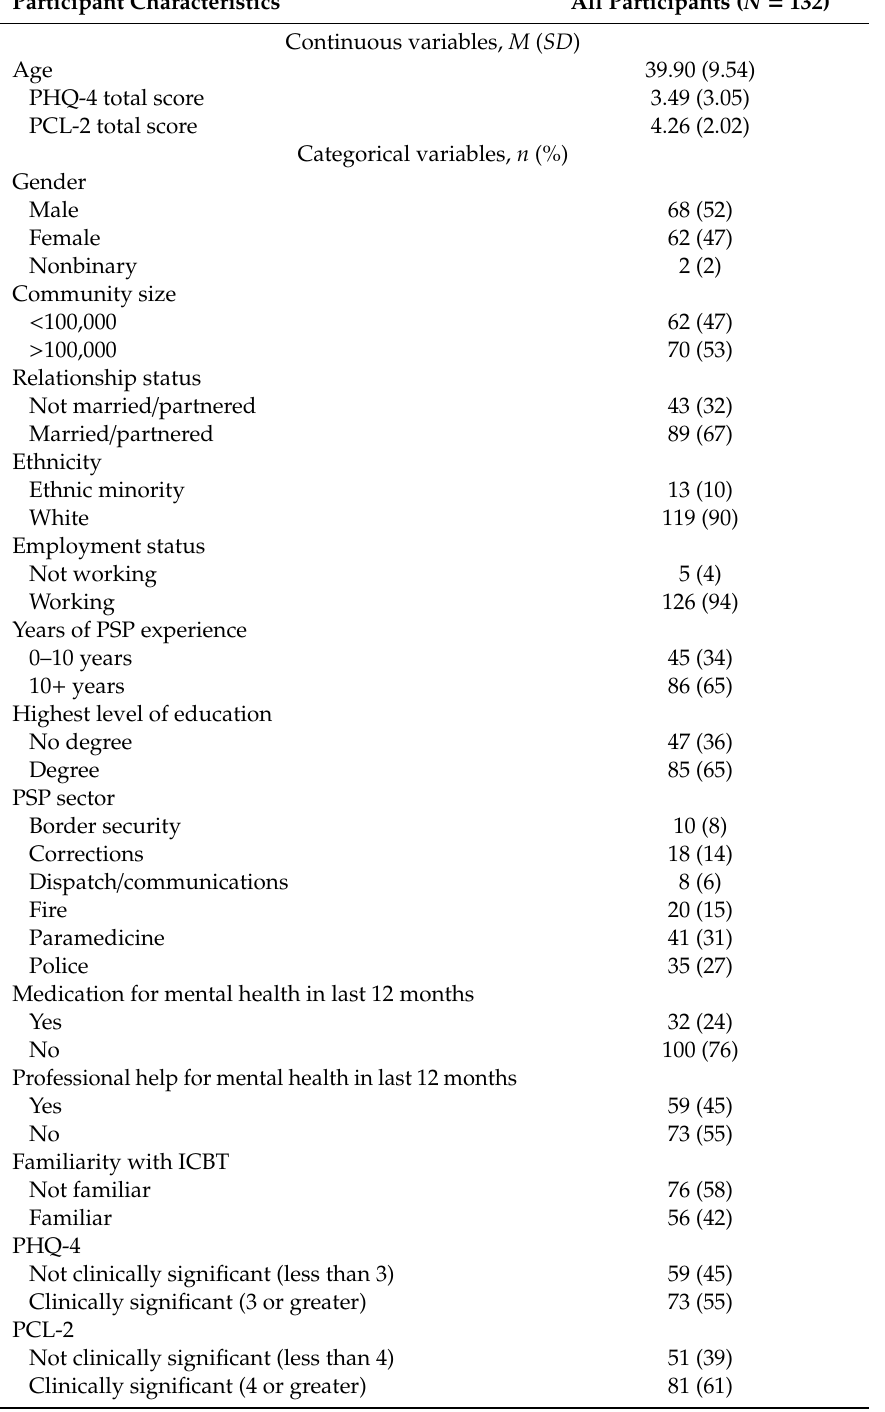
Table 1. Participant demographic and clinical